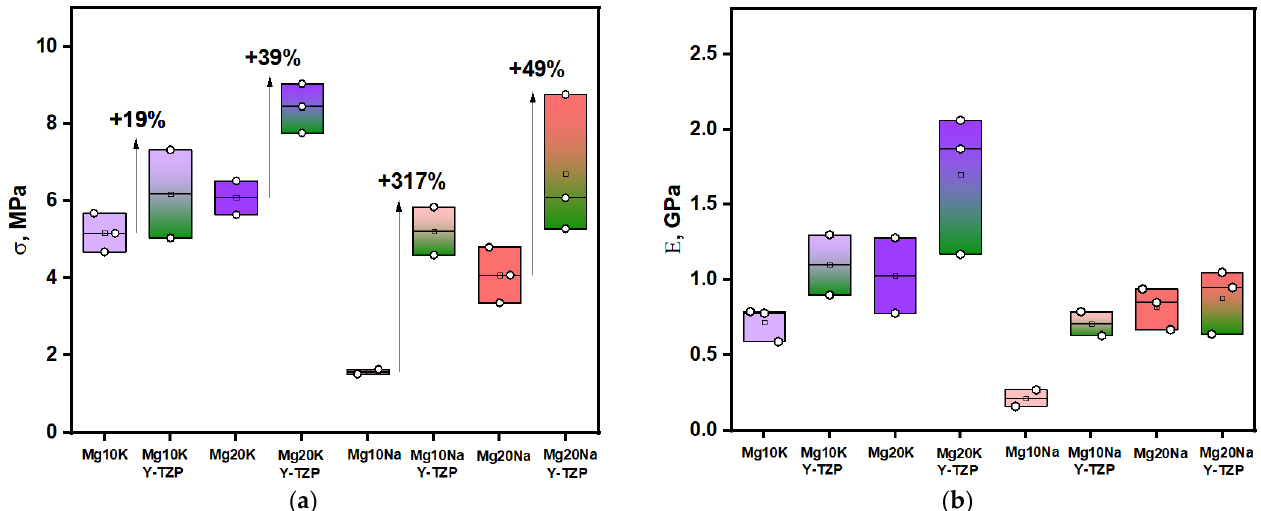
Figure 9. ( a ) Compressive strength of the ceramic samples; ( b ) Young’s modulus of the ceramic